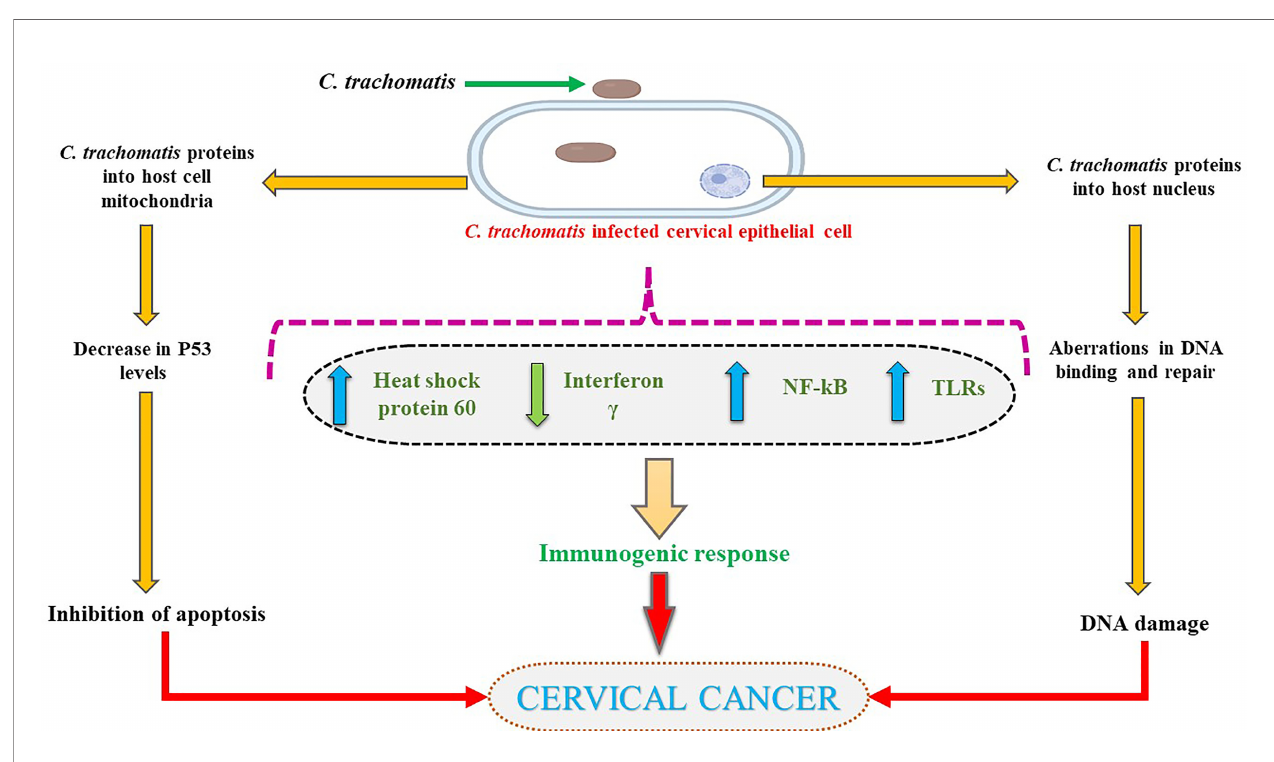
FIGURE 3 | C. trachomatis affecting host cervical